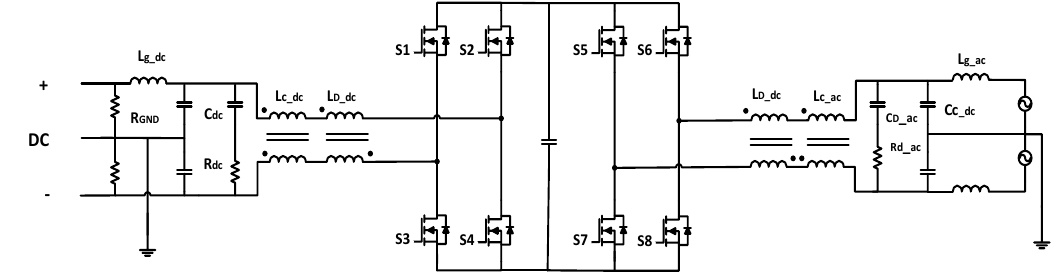
Figure 12. Two-stage bidirectional converter with CM decoupling [57].